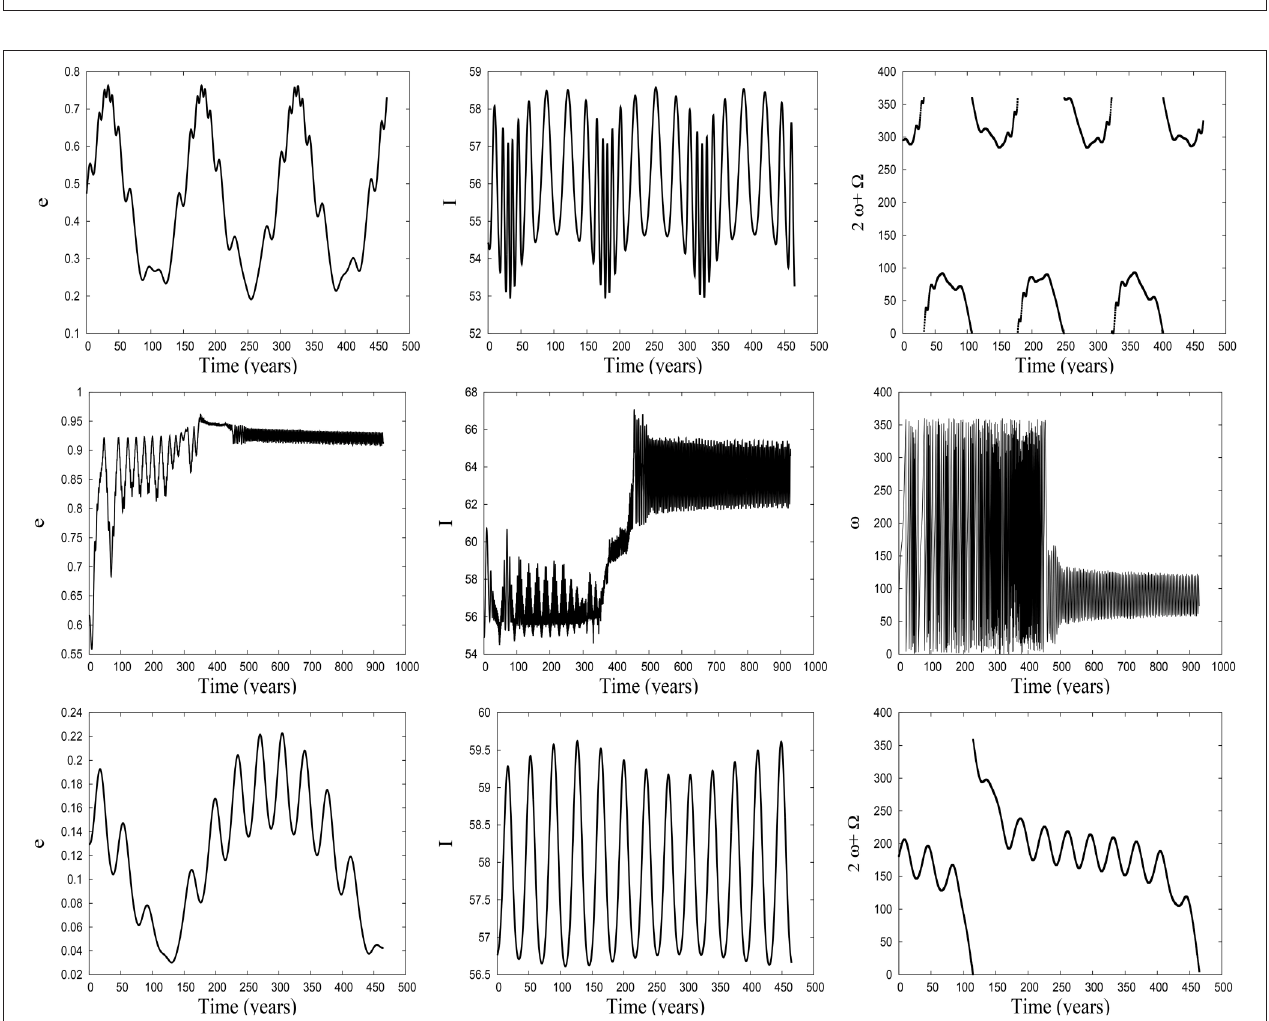
Frontiers in Astronomy and Space Sciences |